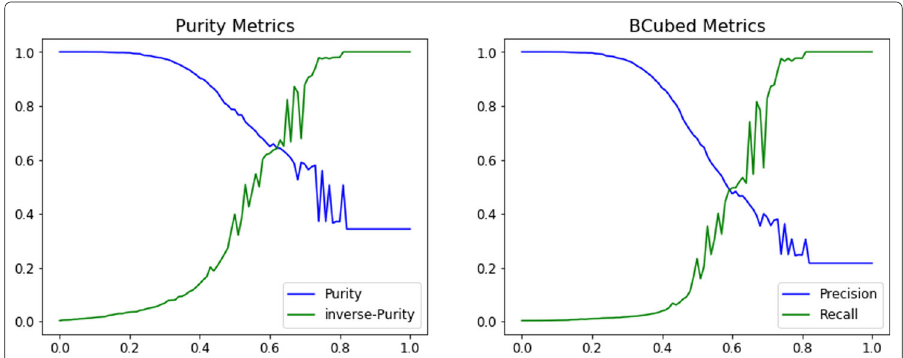
Fig. 11 Precision (purity) and recall (inverse purity) of the top performing semantic role induction approach on the test data. The horizontal axes refer to the neighboring threshold used to create the edges